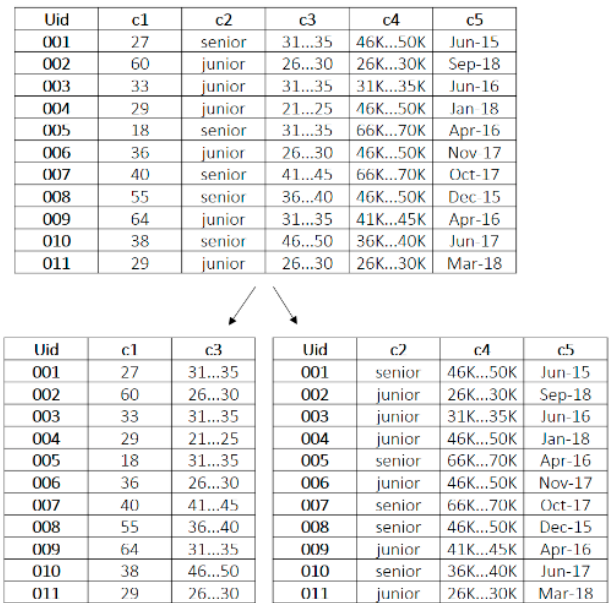
Figure 1. Distributed clustering in homogeneous databases.